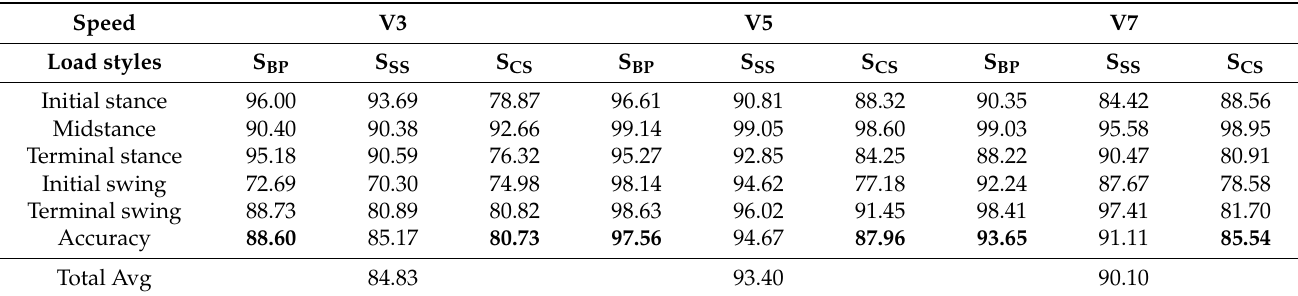
Table 2. Gait phase recognition (%), gait recognition (%) under each load style and speed, and the total average values of gait recognition (%) at three load styles and three